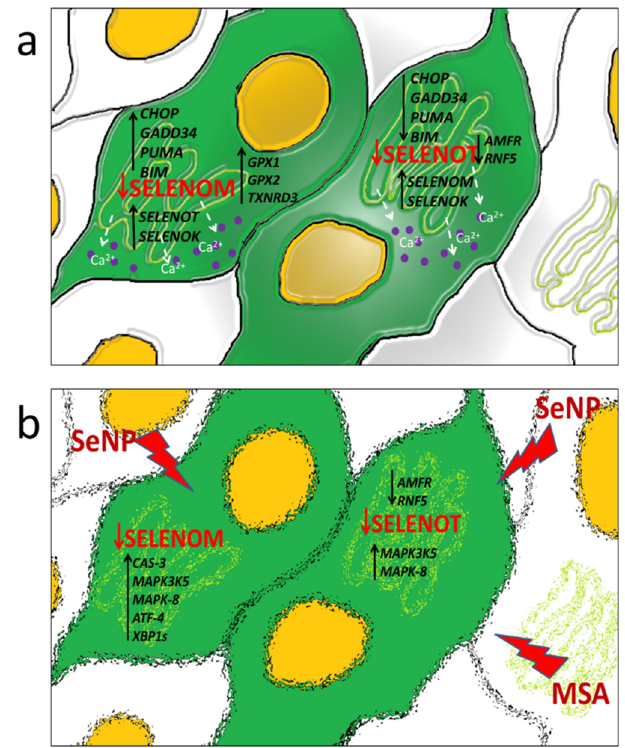
Figure 13. Schematic representation of the effect of SELENOM-KD and SELENOT-KD on the expression of a number of key pro-apoptotic genes, ER stress markers, functional partners of SELENOT, and calcium homeostasis in A-172 cells in the absence of exposure to ER stress inducers ( a ) and after 24 h treatment of cells with 0.1 µM MSA or 5 µg/mL SeNP ( b ).